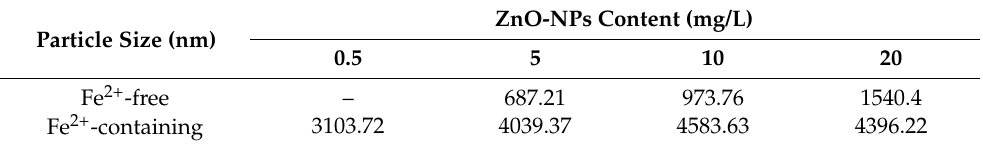
Table 1. Effect of Fe 2+ on the hydrodynamic diameter of ZnO-NPs. Particle Size (nm)